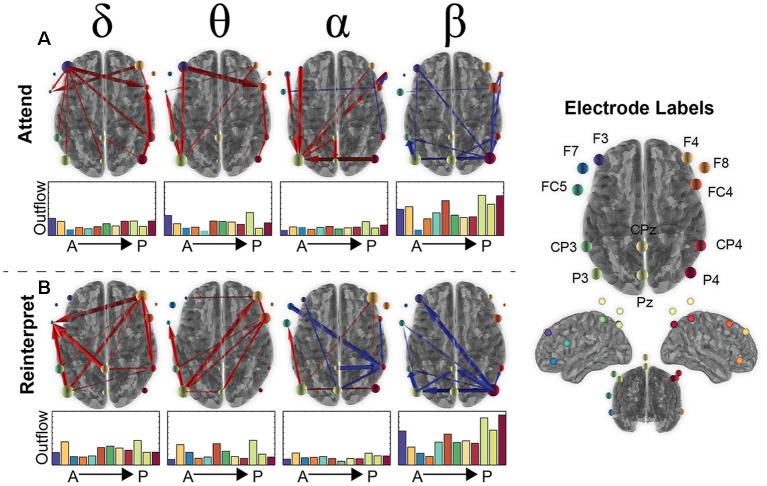
Brain connectivity changes during the second image presentation in the emotion regulation task. (A) The top 90% of connectivity changes in the Attend condition for the 12 electrodes (labels shown on the right) for each frequency band of interest (delta, theta, alpha, beta). Red arrows signify an increase in connectivity compared to baseline (250 ms before onset of second presentation) and blue a decrease from baseline. The total “outflow” (or summed connectivity) for each electrode is visualized by scaling the orb size as well as bar plots under each axial brain image that are organized from anterior to posterior electrodes (color of bar plot matches the color of the circle in the electrode label picture). (B) The same information for the Reinterpret condition as shown in (A) for Attend.